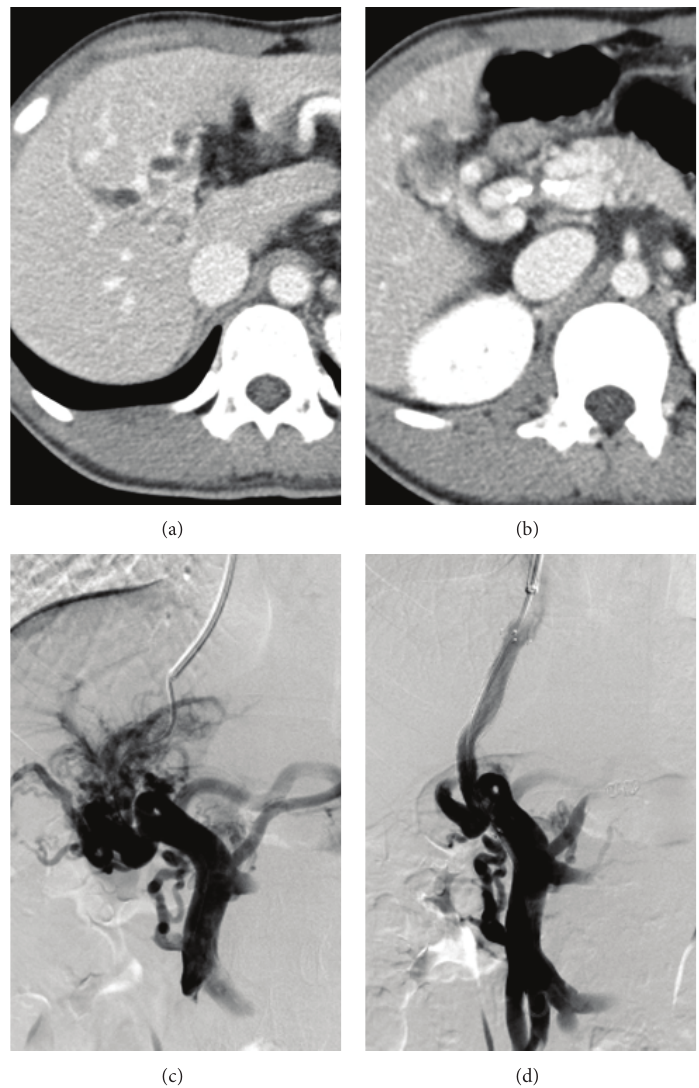
Figure 1: TIPS placement and recanalization of a segmental occluded main portal vein in a 26-year-old man with portal cavernoma. (a-b) CT scan shows occlusion of the portal vein at the hepatic hilum and partial patent main portal vein. (c) Portal venogram following access into the portal venous system reveals occlusion of the main portal vein and numerous collateral veins around the hilum. (d) Final portography obtained after TIPS placement with the distal end of the stent into the main portal vein demonstrates a good backflow through the